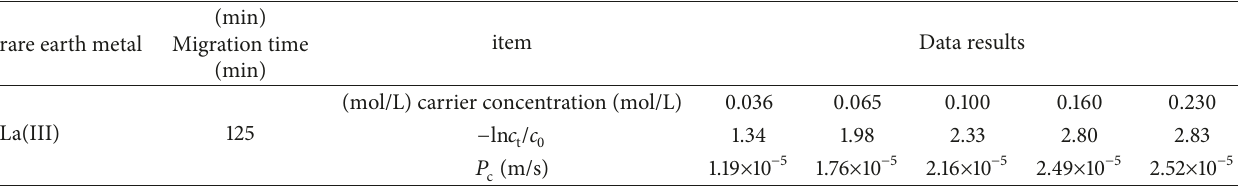
Table 5: Effect of carrier concentration on transport of rare earths.